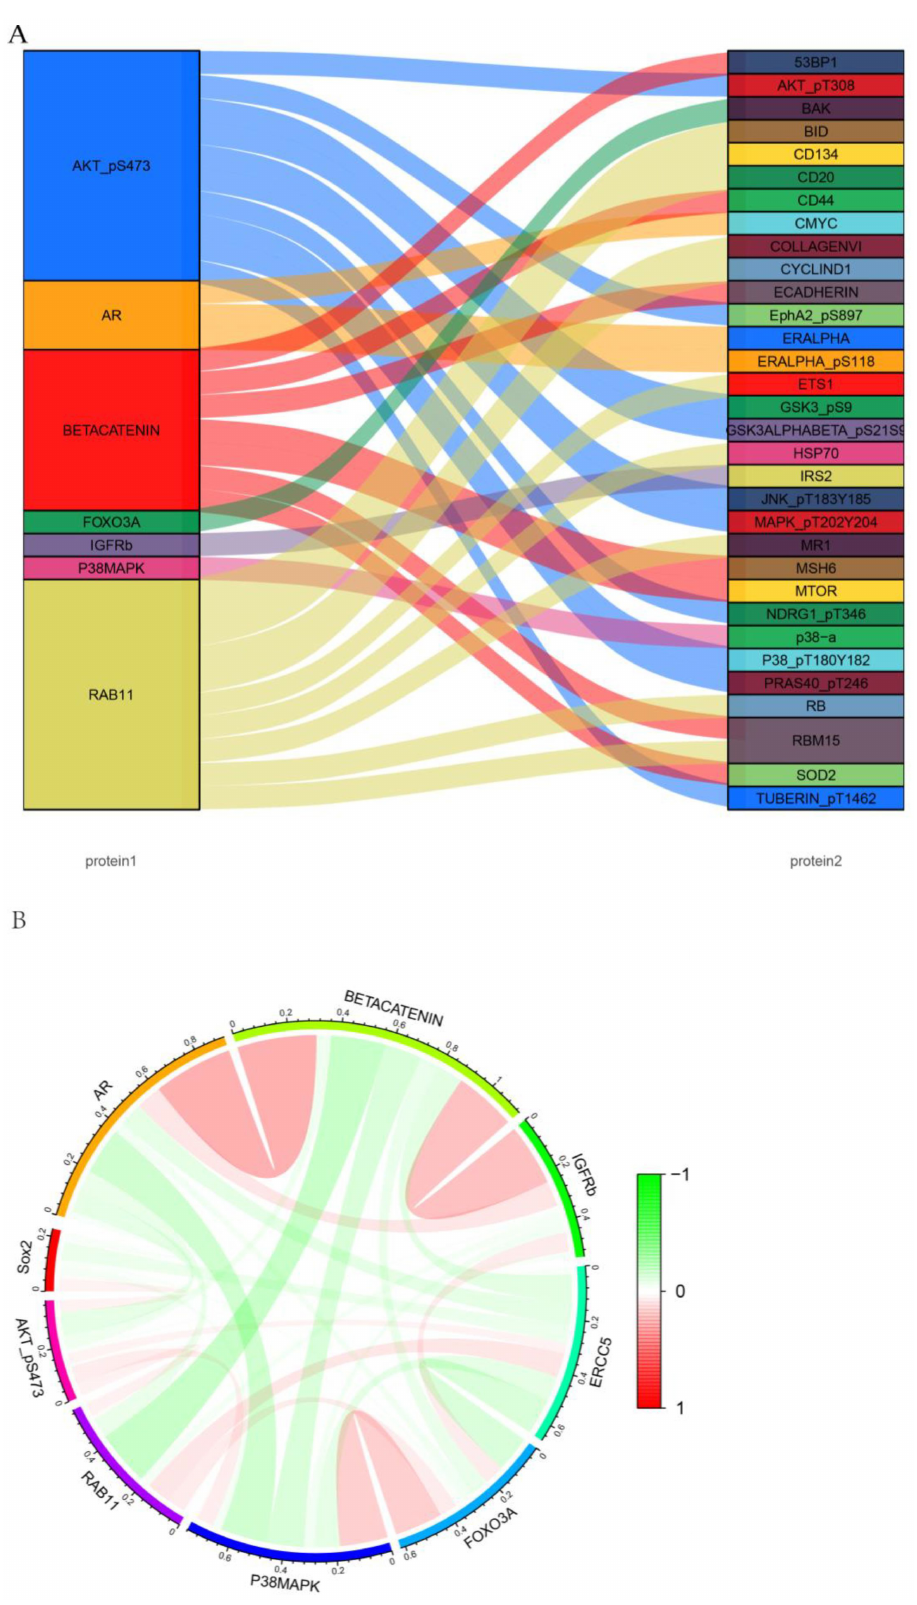
Figure 6. Analysis of co-expressed proteins and relationships between proteins. ( A ) Sankey diagram of the co-expression of the nine signature proteins. ( B ) Circle plot showing the relationships between the nine signature